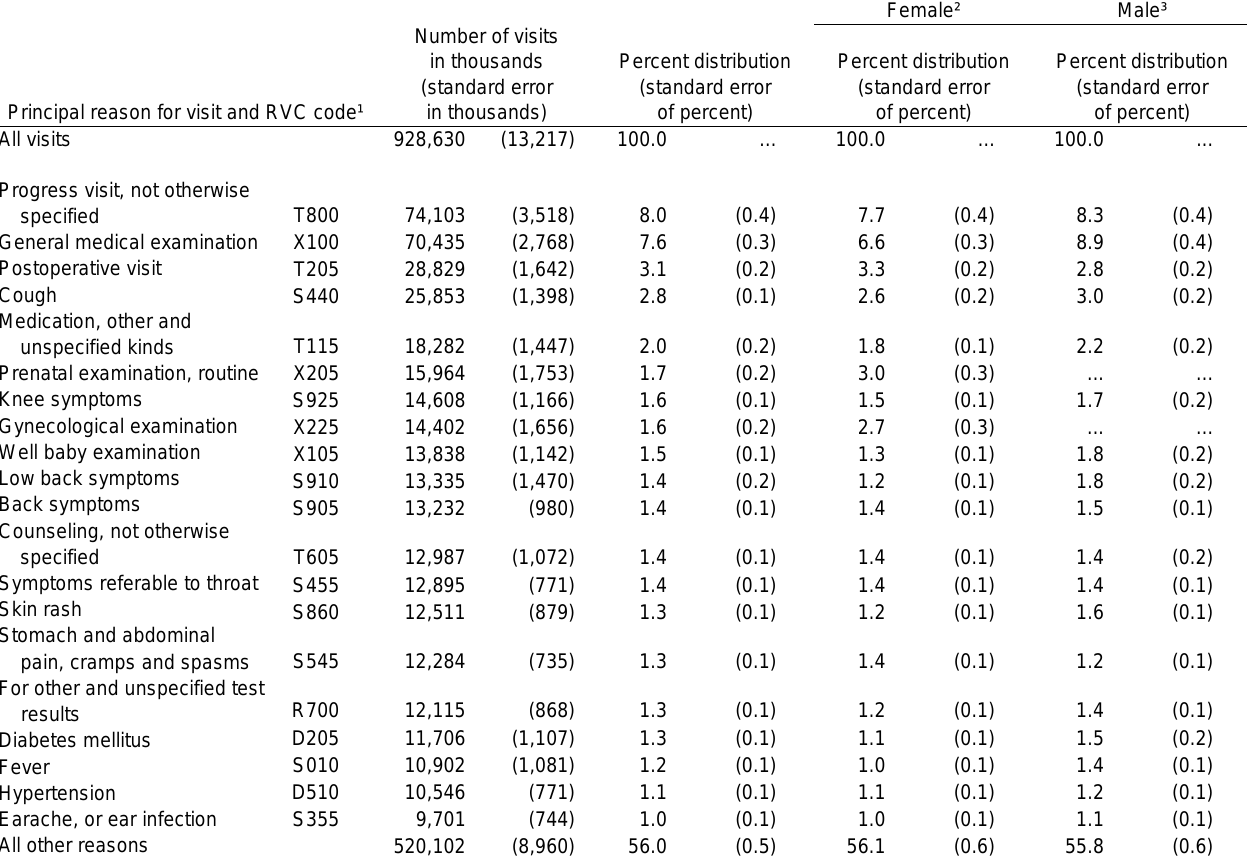
Table 11. Twenty leading principal reasons for office visits, by patient's sex: United States,